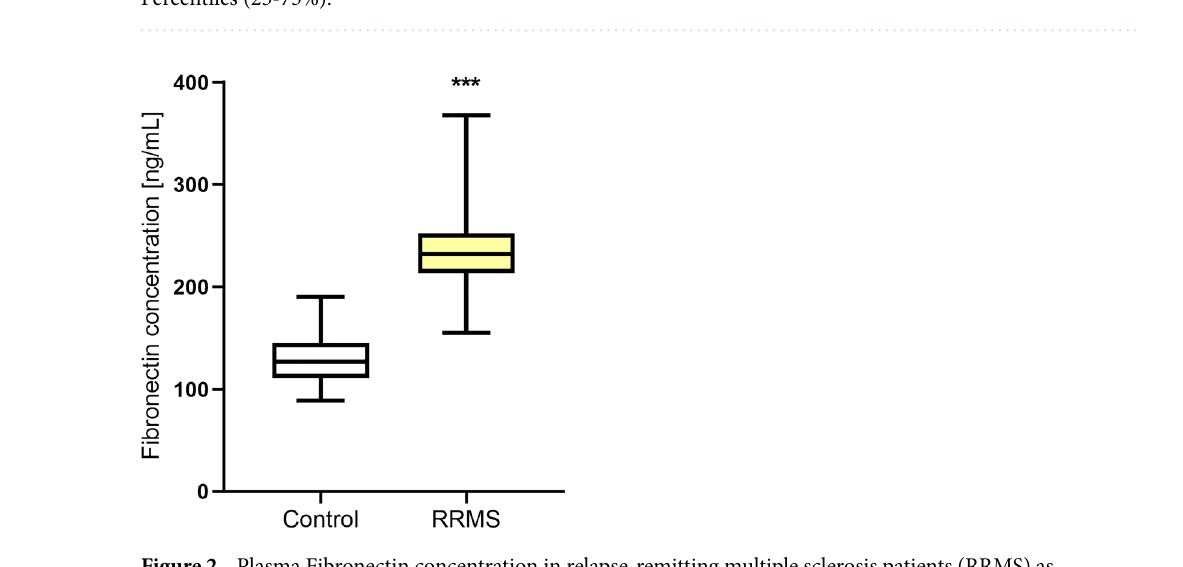
Table 4. Plasma leptin, fibronectin, and UCHL1 concentration depending on the EDSS value in MS patients. MS multiple sclerosis, EDSS Kurtzke’s Expanded Disability Status Scale. Data is presented as Median with the Percentiles (25-75%).